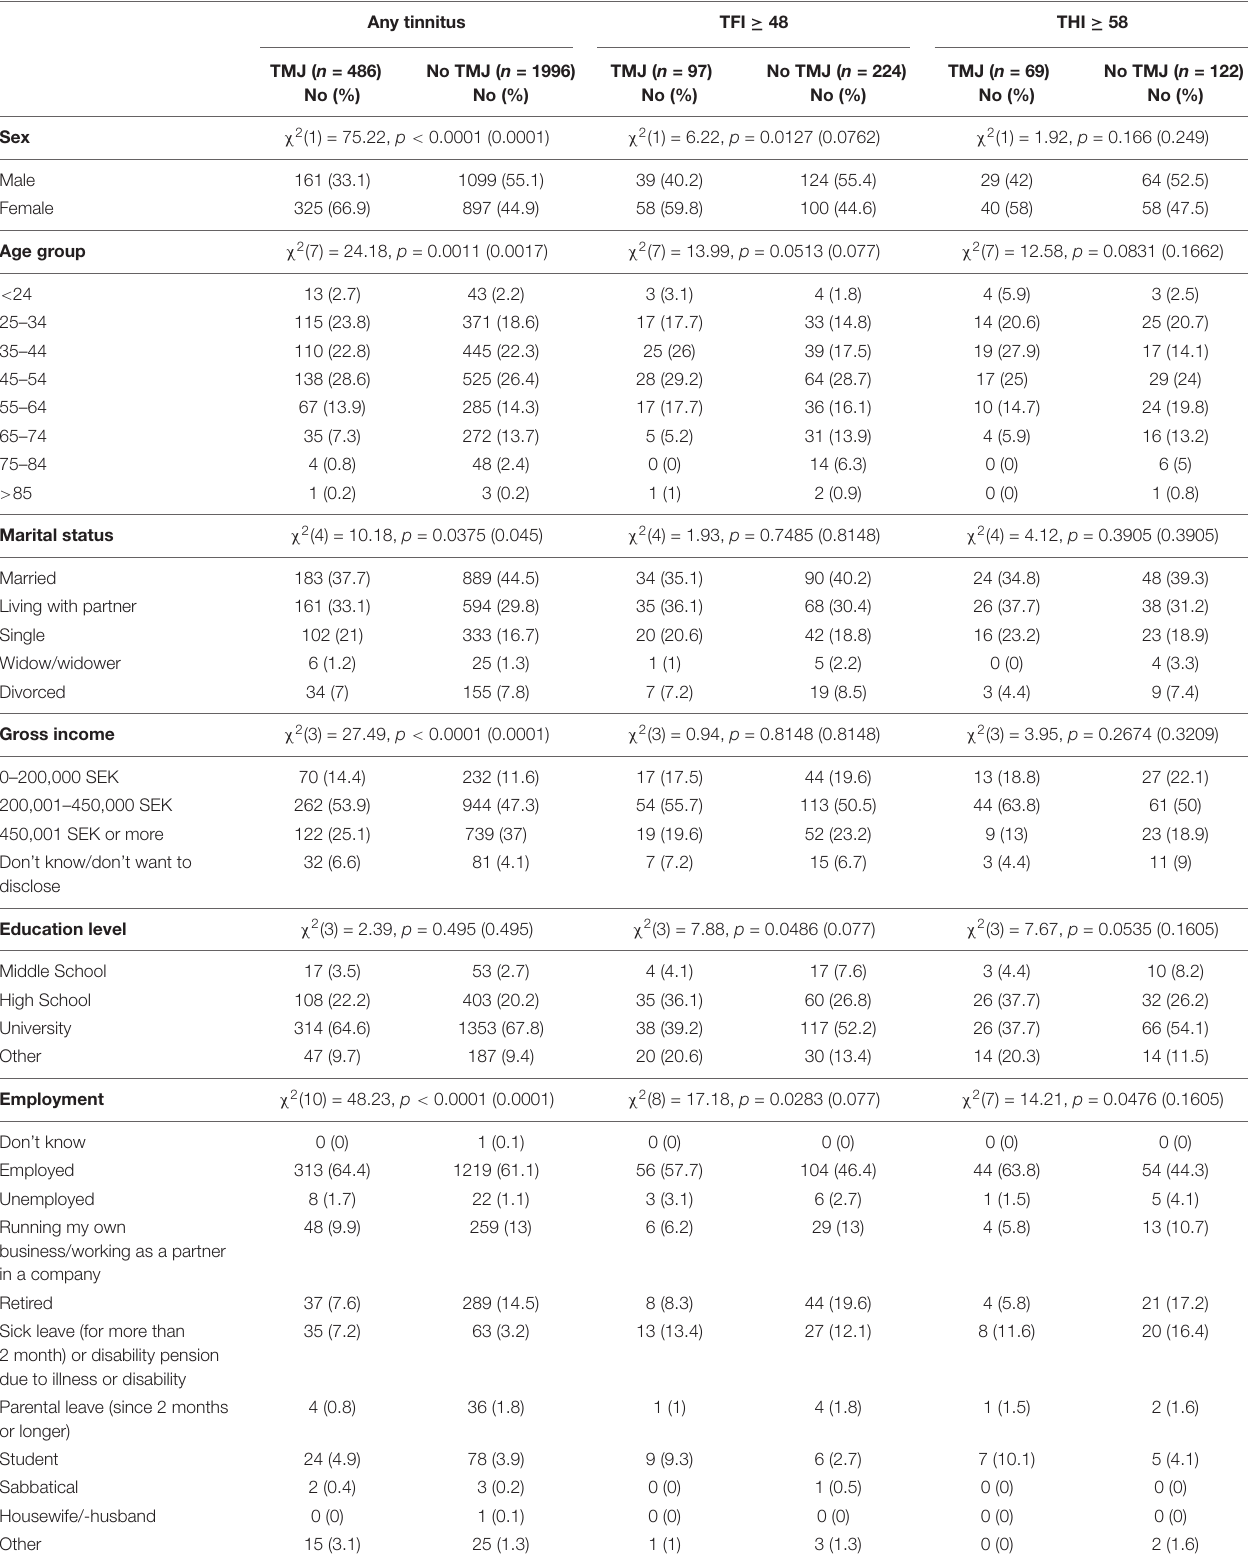
TABLE 1 | Sociodemographic characteristics for subjects with tinnitus with or without TMJ complaints. Any tinnitus TFI ≥